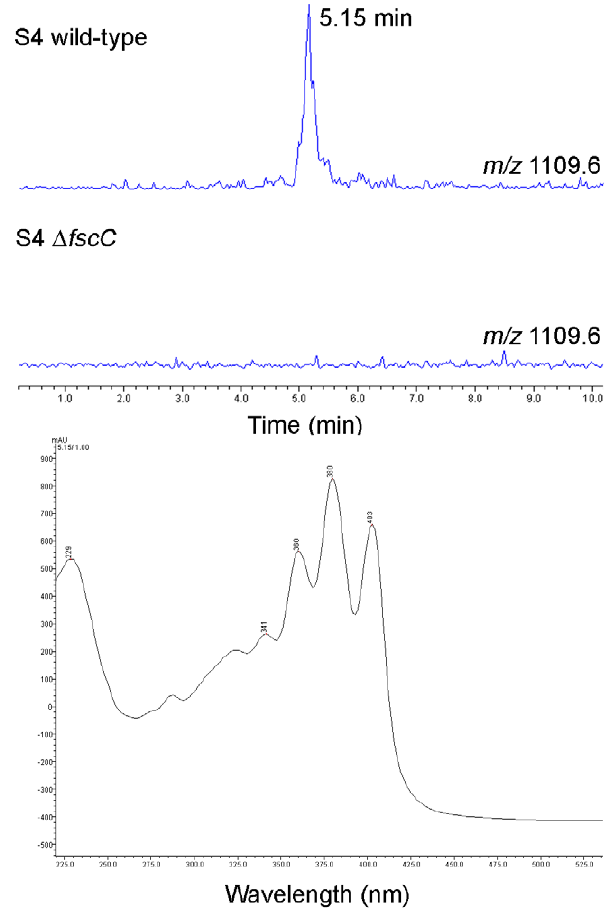
Figure 1. Deletion of the candicidin biosynthetic gene, fscC abolishes production of candicidin. LC-MS was used to analyze supernatant from Streptomyces S4 wild-type and S4 D fscC . The extracted ion chromatogram for candicidin ( m/z 1109.6) is shown and confirmed that only S4 wild-type and not the D fscC mutant produced candicidin. The UV visible spectra for the peak at RT 5.15 min displays absorption characteristics consistent with polyene compounds is also shown